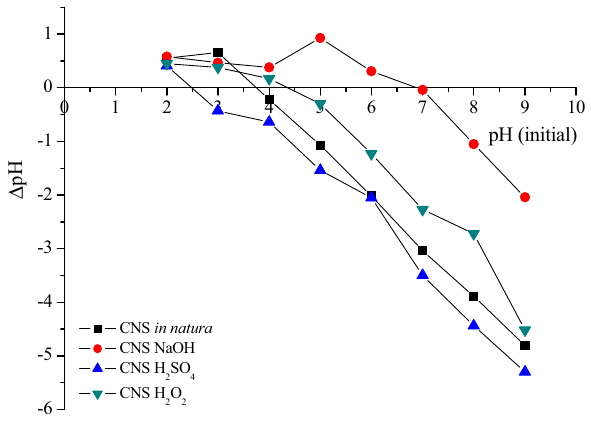
Fig. 3 Point of zero charge (pH 2014) and modified with H 2 O 2 , H 2 SO 4 and